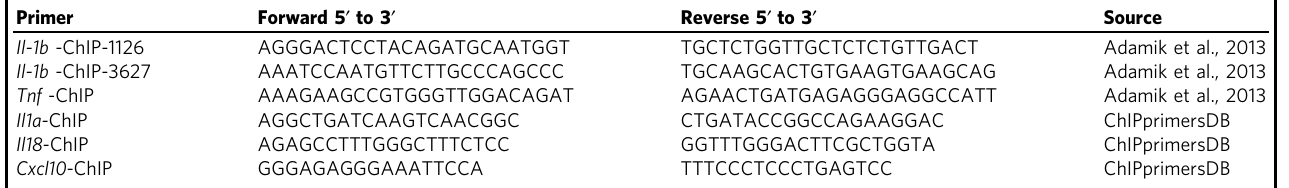
Table 2 Primers for